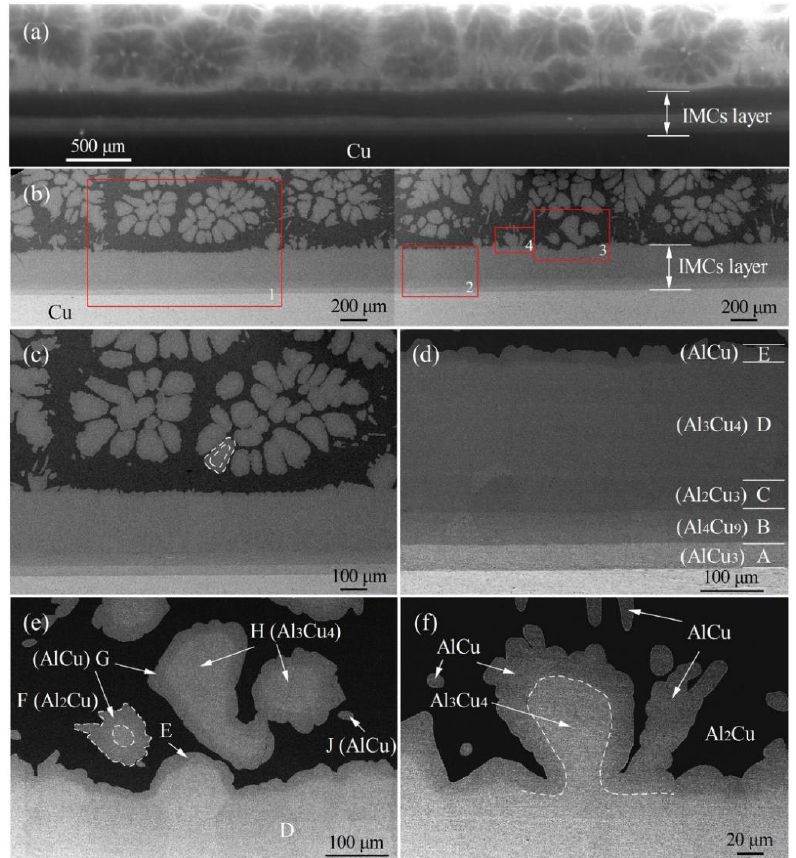
Figure 5. Characterization of interfacial microstructure in Al/Cu sample: ( a ) in situ radiograph, ( b ) SEM image corresponding to Figure 5a, ( c – f ) enlarged images of red rectangular areas in Figure 5b.